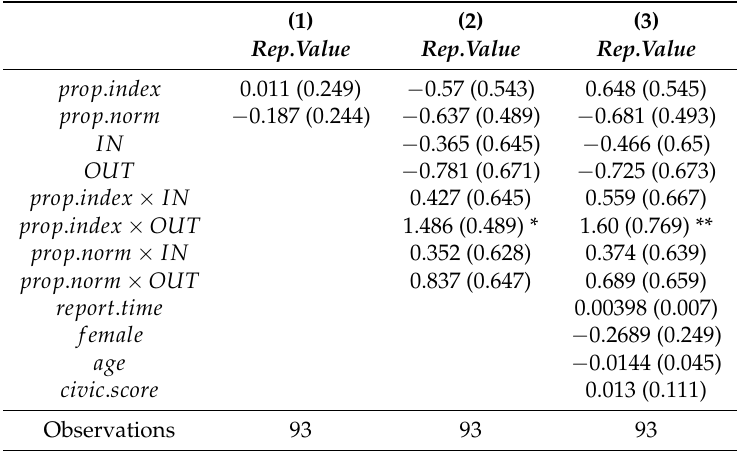
Table 4. Recipients’ self-reported values (ordered probit